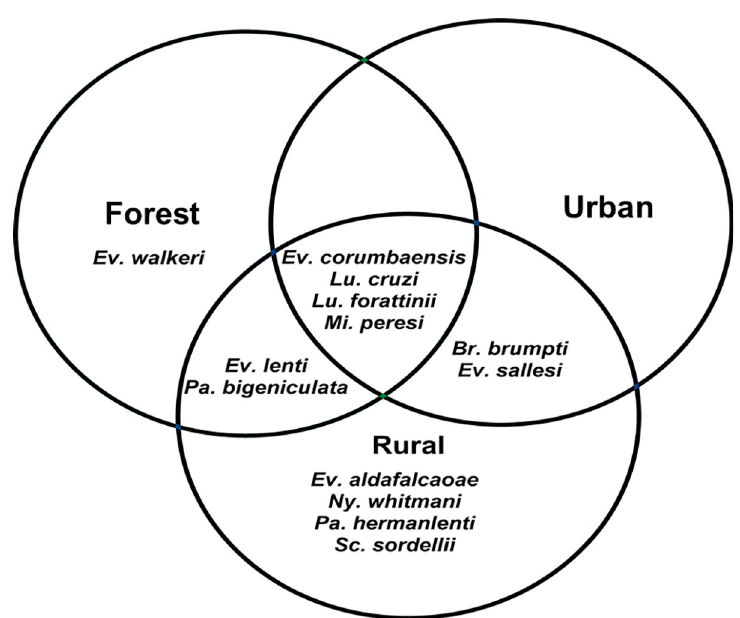
Fig 9. Distribution of sandfly species in three areas (forested, rural, urban). Corumba´, Mato Grosso do Sul, Brazil. May 2015 to April 2017.